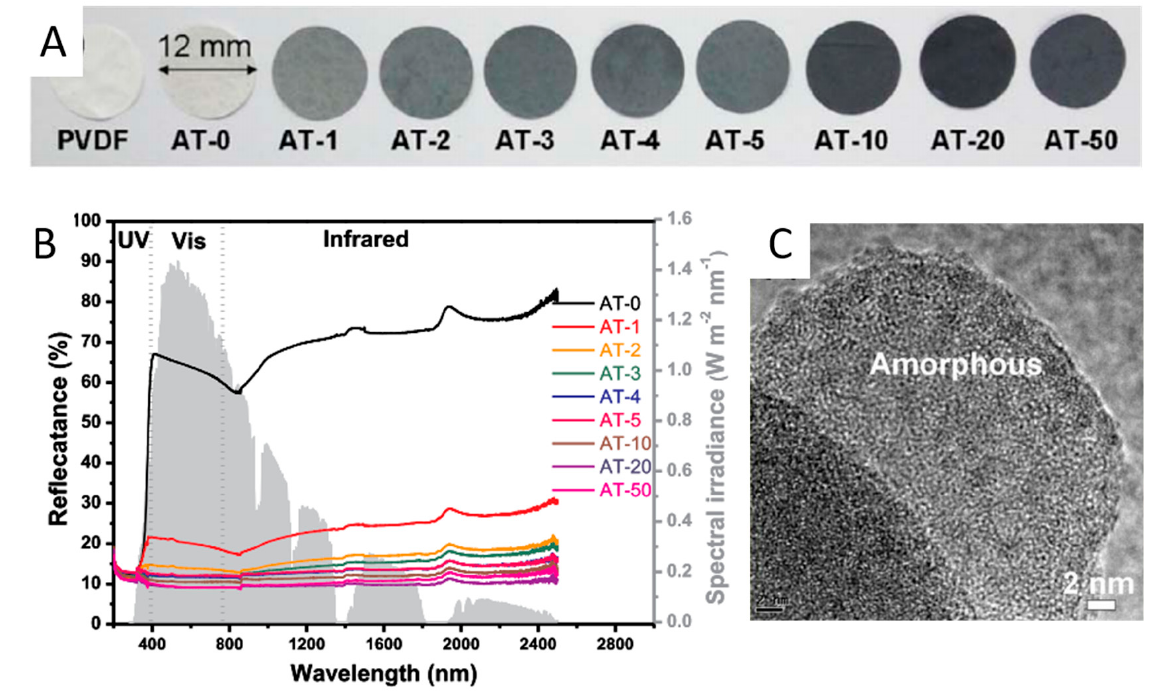
Figure 7. ( A ) the set of the AT-x (Al-Ti-O-milling time) membranes; ( B ) UV-Vis-NIR diffuse reflectance spectra of AT-x; ( C ) TEM image of Al-black TiO 2 . Reprinted with permission for ref. [94]. Copyright 2017, Elsevier.